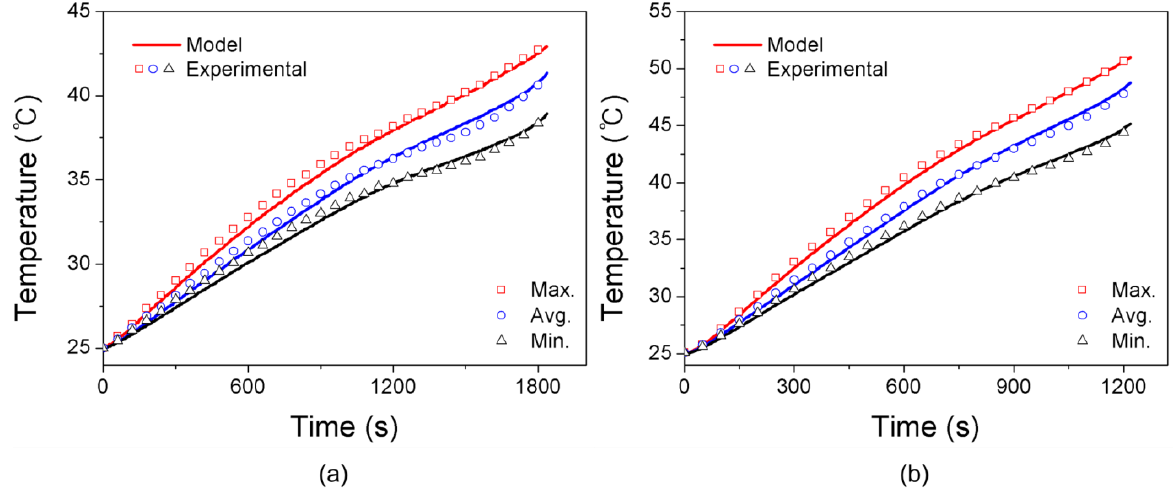
Figure 4. Comparison between the maximum, average, and minimum temperatures from the experiment and modeling at the discharge rates of ( a ) 2 C and ( b ) 3